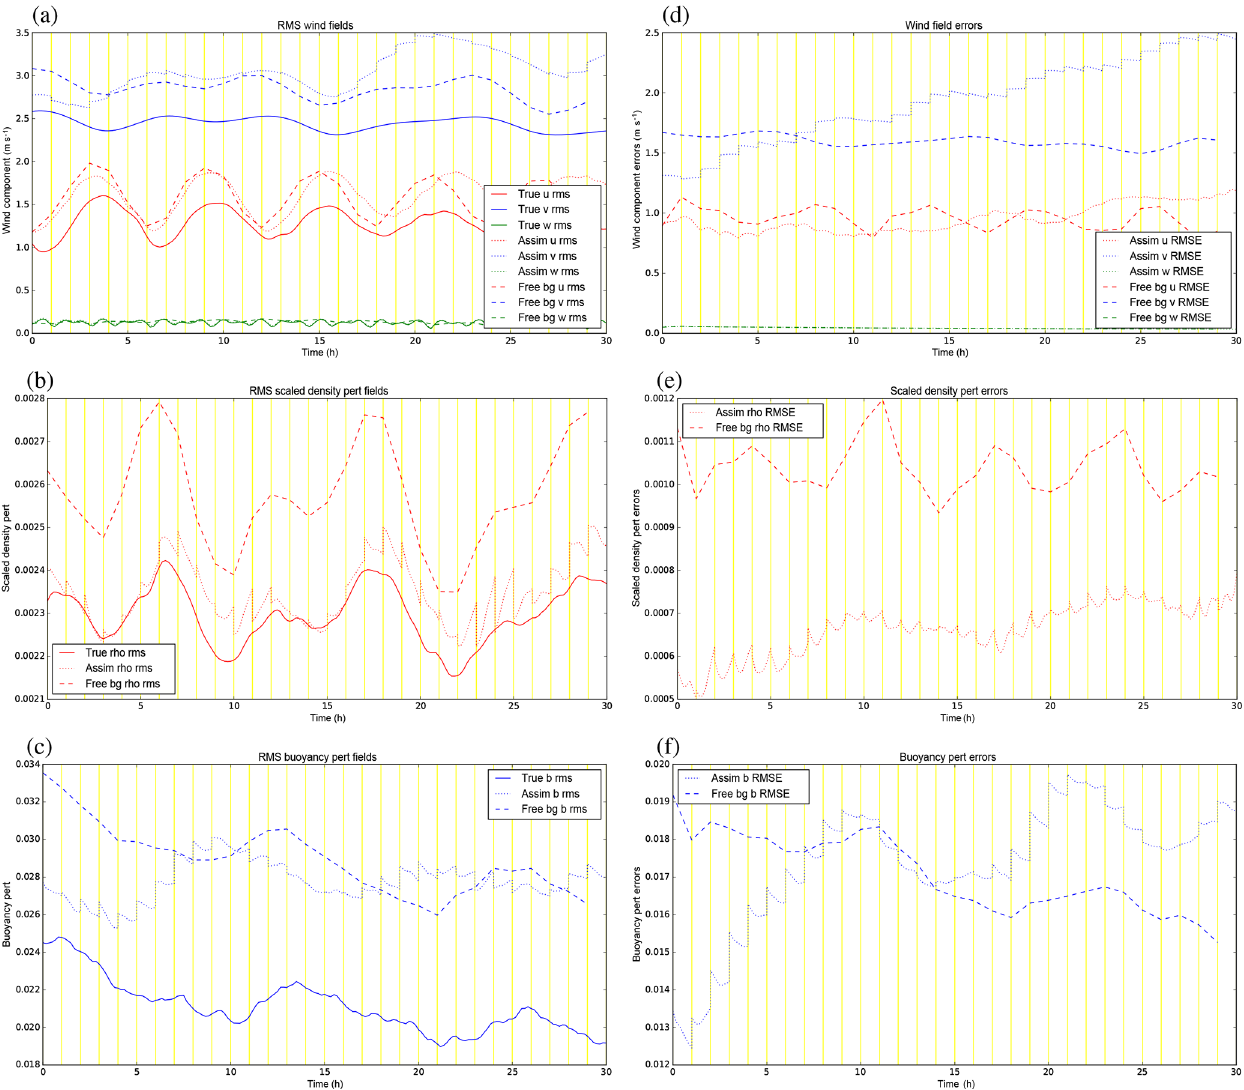
Figure 11. (a–c) The rms fields of (a) u , v , w , (b) ˜ ρ ’, and (c) b (cid:48) for the control experiment, GB + VR + . The solid lines are for the truth trajec- tory, the dotted lines are for the assimilation trajectory, and the dashed lines are for the free trajectories starting from the initial background. The vertical yellow lines mark the times of the cycle boundaries where the assimilation trajectory is the analysis at the start of each cycle and the background (for the next cycle) at the end. (d–f) The rms values of the errors (trajectory minus truth) for the corresponding quantities in (a–c)